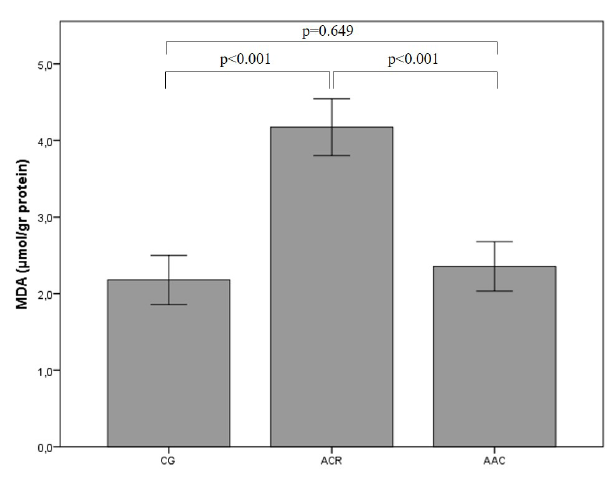
FIGURE 2 - Comparison of the malondialdehyde (MDA) levels between study groups. Bars represent mean ± standard deviation. CG control group, ACR acrylamide-treated group, AAC anakinra + acrylamide-treated group.